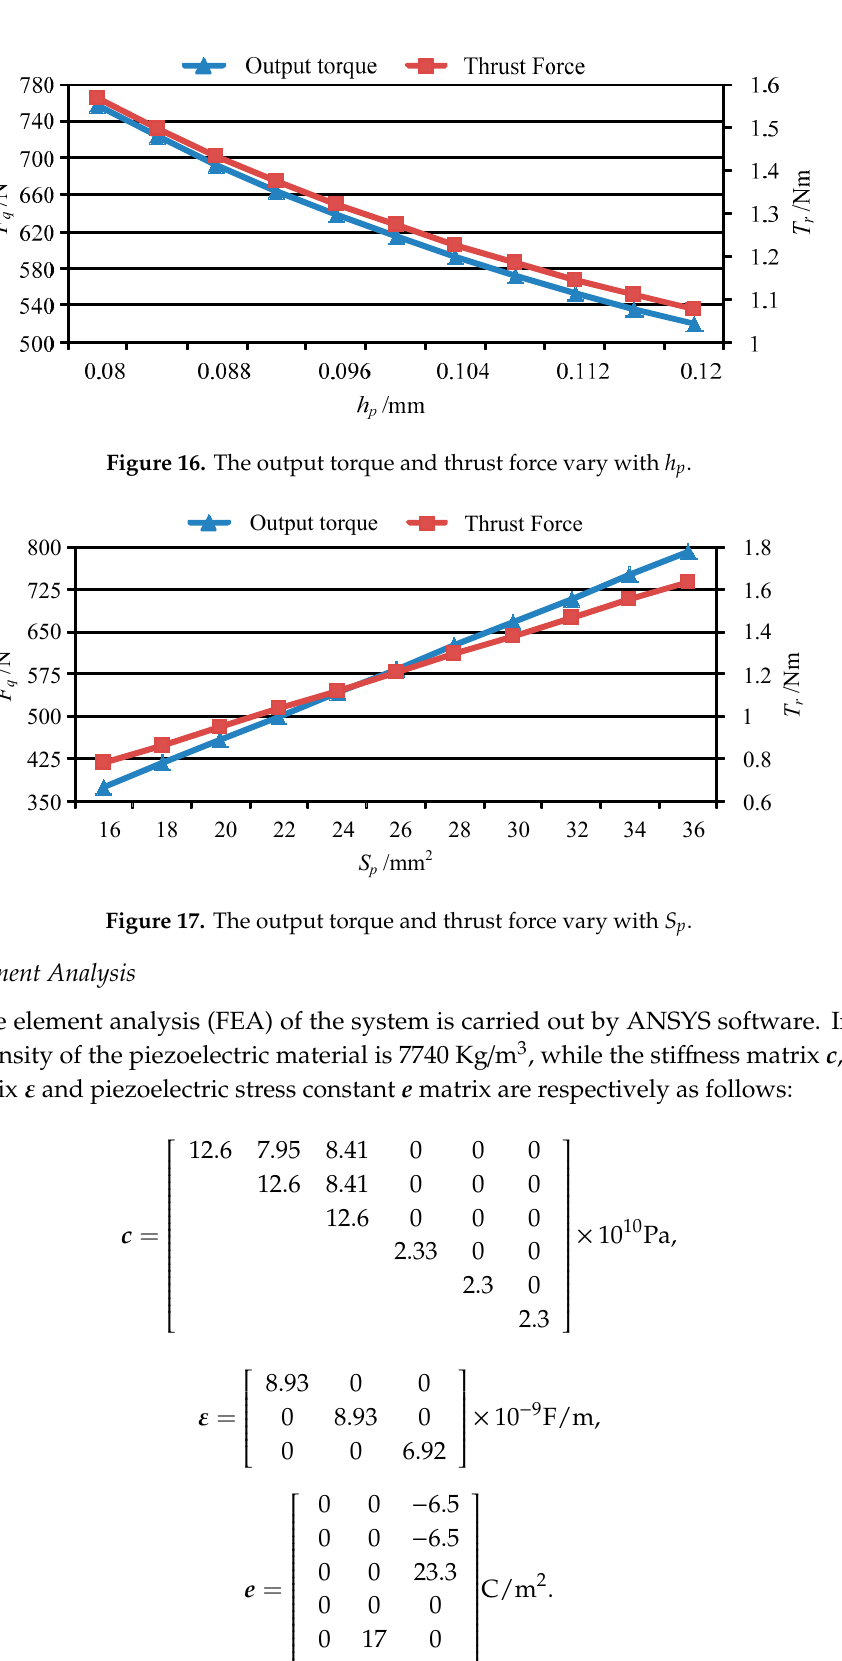
15 of 22 Figure 13. The output torque and thrust force vary with U p . Figure 14. The output torque and thrust force vary with d 33 .